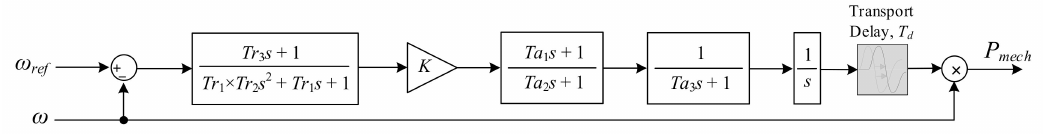
Figure A1. A governor and diesel engine block